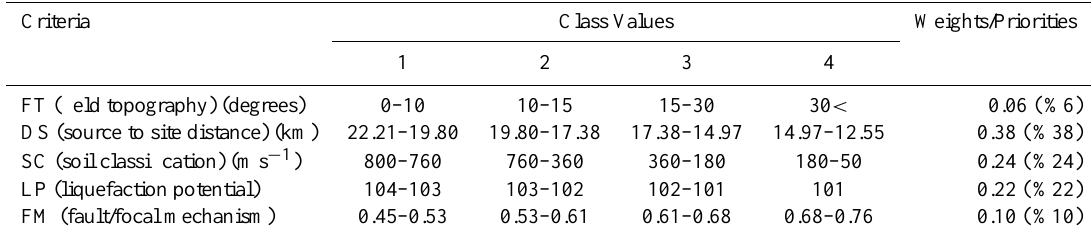
Table 1. Criteria value ranges and their assigned class values with the calculated criteria priority/weight.